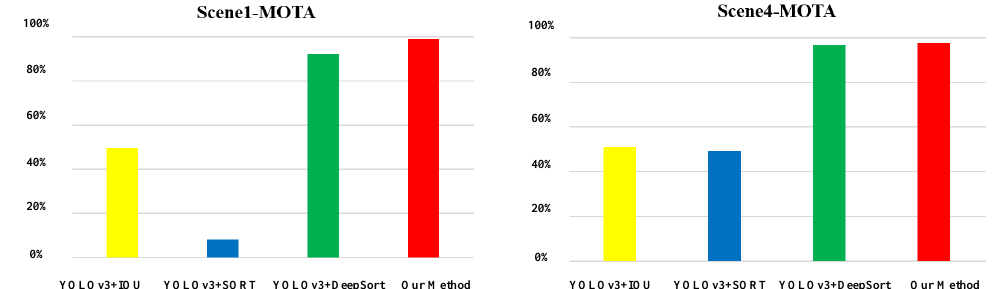
Figure 14. Histogram of tracking-performance parameter MOTA of four tracking methods. The MOTA of: YOLOv3 + IOU in Scenes 1 and 4 was 98.94% and 97.56%, YOLOv3 + SORT in Scenes 1 and 4 was 98.94% and 97.56%, and YOLOv3 + DeepSort in Scenes 1 and 4 was 98.94% and 97.56%. The MOTA of our method was 98.94% and 97.56% in Scenes 1 and 4, which was better than the three other